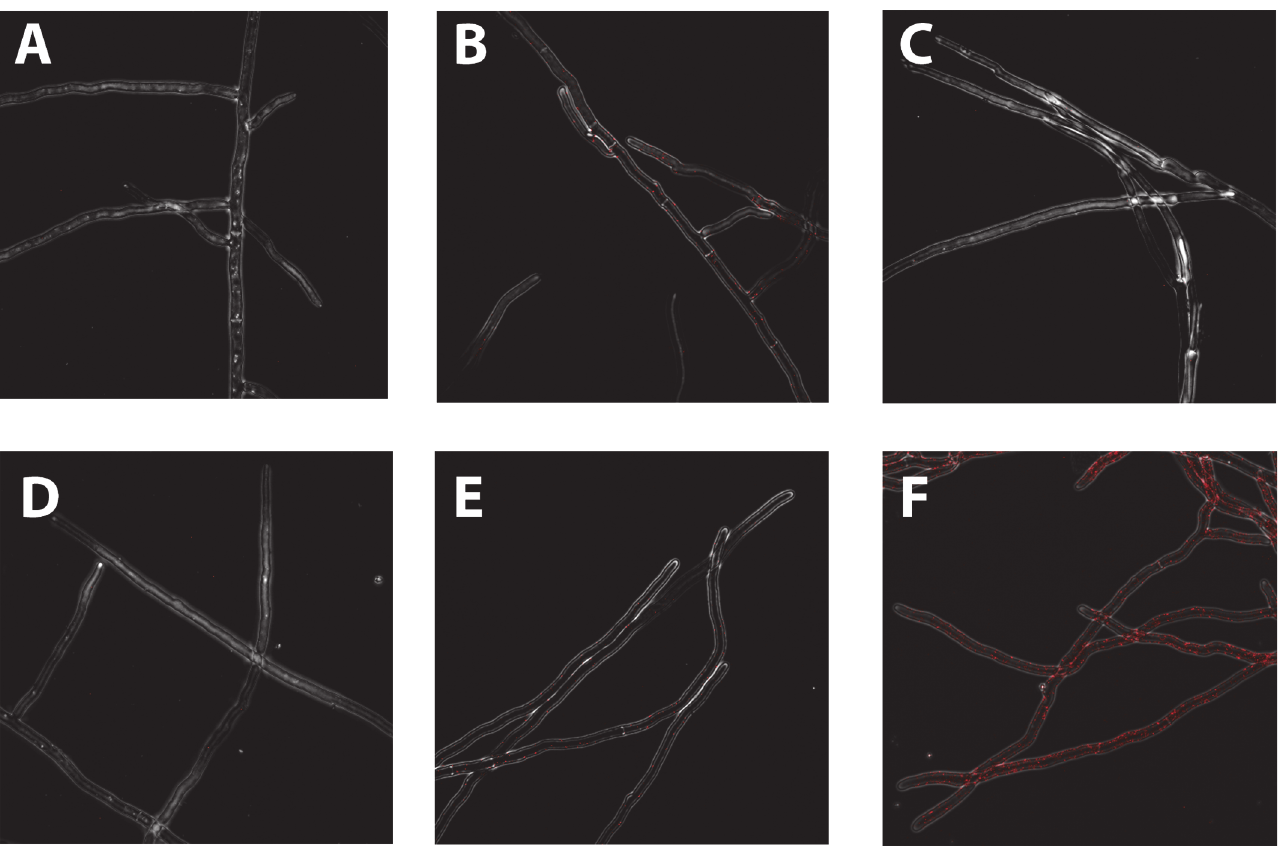
Fig 1. Immunostaining of hyphae with a specific β -1,3;1,4 glucan antibody. A. No primary antibody Af293(WT) control. β -1,3;1,4-glucan staining of B. WT.; C. β -1,3;1,4-glucanase digested WT(only WT shown; other digested strains were also negative for staining); D. tft1 Δ ; E. Revtft1; and F.